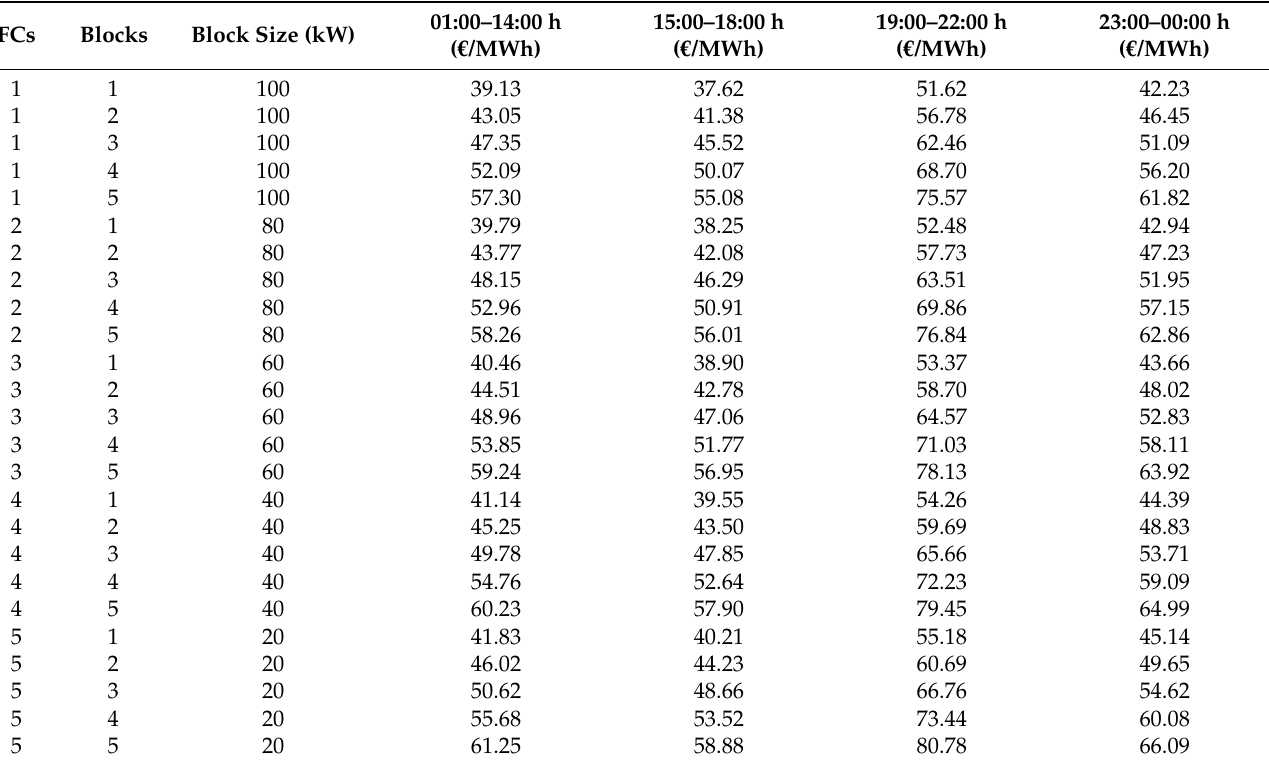
Table 4. Structure of the forward contracts